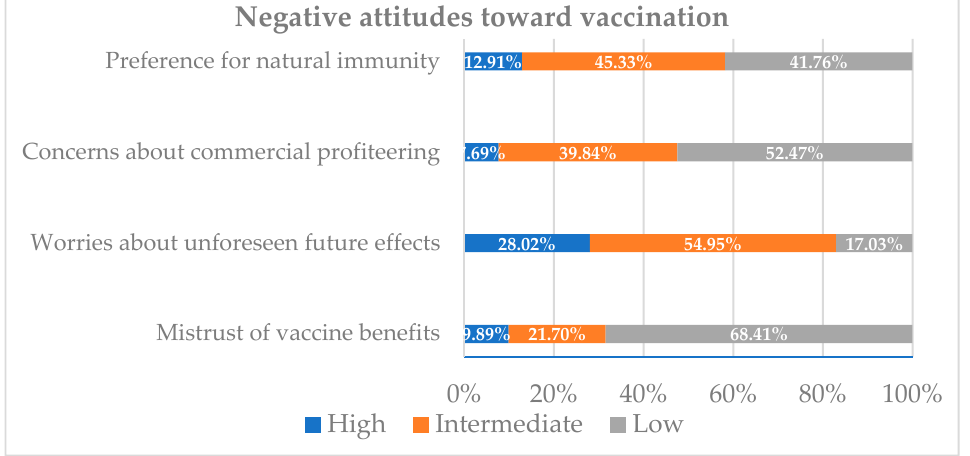
Figure 5. Proportion of the sample reporting high, intermediate, and low negative attitudes towards vaccines.